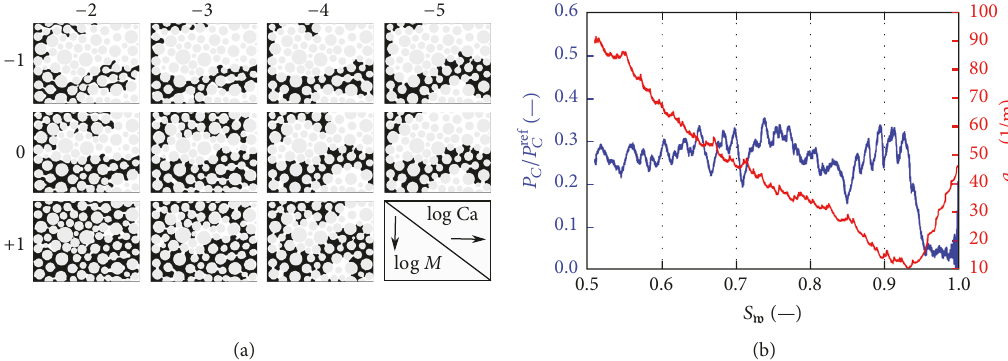
Figure 2: (a) NWP distributions (black) at breakthrough for microstructure C in ( Ca ,𝑀) feature plane. Solid phase and WP are colored gray and white, respectively. (b) Normalized macroscopic capillary pressure 𝑃 𝐶 (𝑆 w )/𝑃 ref 𝐶 and specific fluid interfacial area 𝑎 wn (𝑆 w ) for capillary- dominated primary drainage in microstructure C at log 10 ( Ca ,𝑀) = (−5,0) . During the preentry regime, 𝑃 𝐶 increases to the entry capillary pressure level while 𝑎 wn (𝑆 w ) decreases as the meniscus comes in contact with the solid phase. During the postentry regime, 𝑃 𝐶 exhibits a constant mean value with fluctuations related to spontaneous Haines